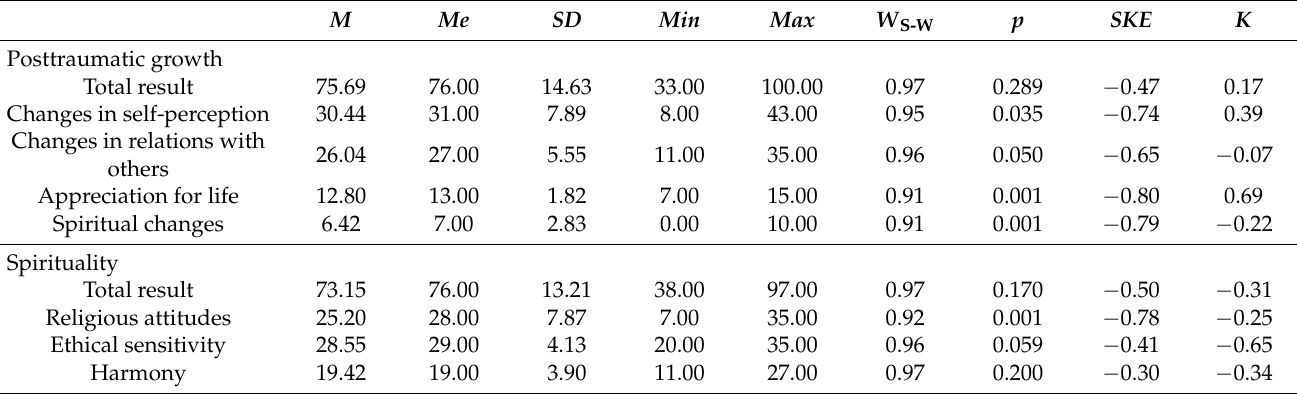
Table 3. Descriptive statistics of the studied variables ( n =